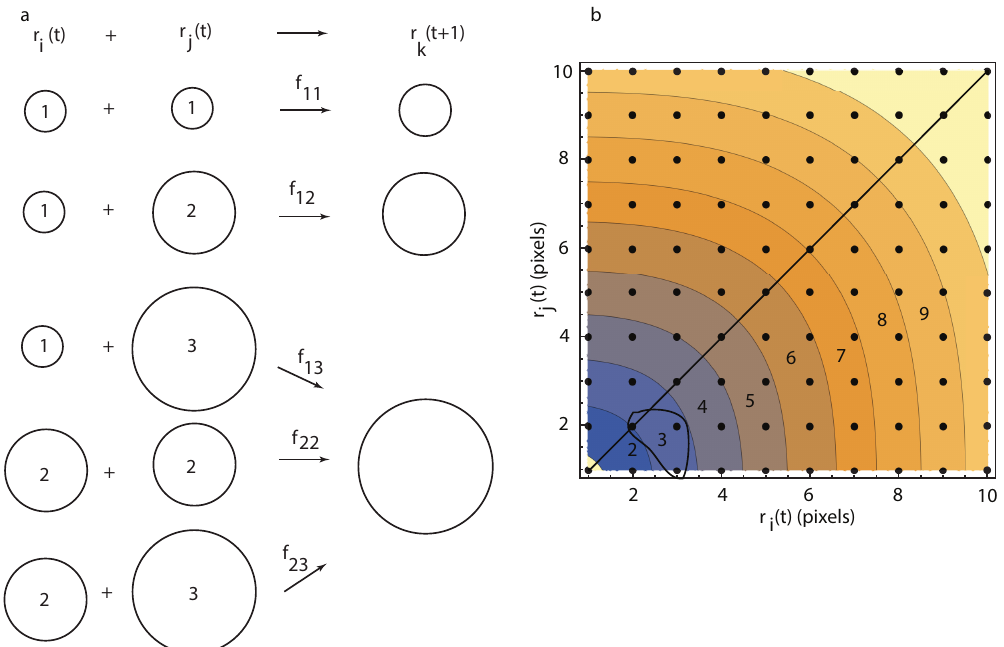
Figure 5. ( a ) binary collisions between droplets of radii r i ( t ) and r j ( t ) lead to a larger droplet of radius r k ( t + 1 ) with a collision transition rate f ij . As the resultant droplet radius (binned in increments of one pixel) increased, the multiplicity of possible combinations increases. The number inside the circles symbolizing droplets represents their radii (in pixels) before coalescence; ( b ) the two-dimensional state space of the system at time step t shows all possible pairs of liquid droplet radii r i ( t ) and r j ( t ) < r i ( t ) (below continuous diagonal line) that could lead to a new droplet of radius r k at iteration t + 1. Each shaded contour plot covers a 1-pixel bin. For example, the shaded contour label with three pixels shows that it is the result of three possible types of coalescence events between droplets of following sizes: two pixels and two pixels, or one pixel and three pixels, or two pixels and three